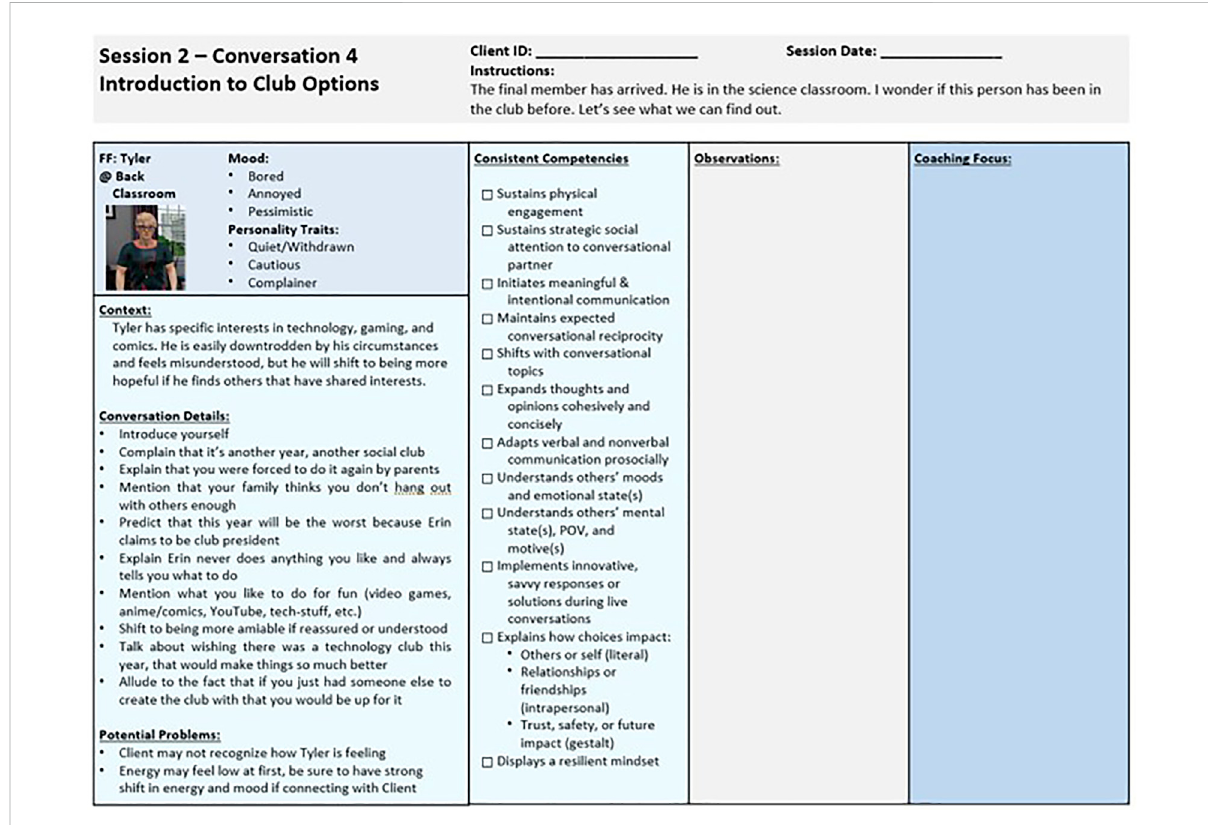
FIGURE 5 Conversations are outlined in the session manual to provide some guidance, while maintaining the opportunity for dynamic